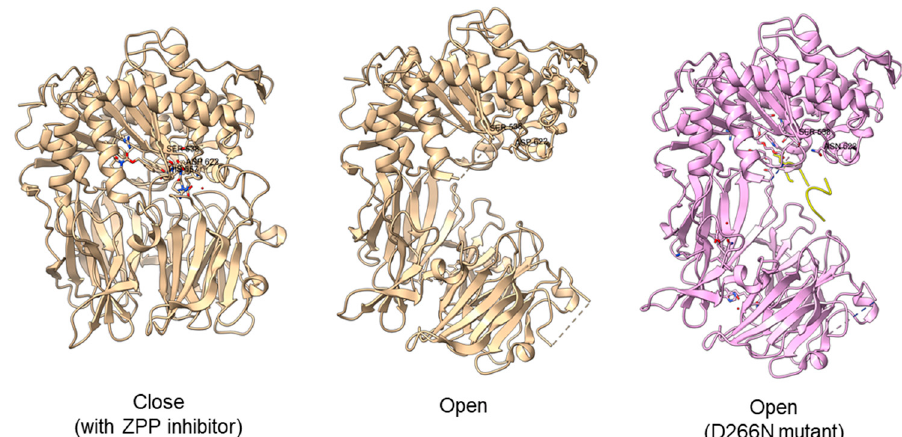
Figure 6. Crystal structures of Aeromonas punctata PEP (ApPEP). From left to right: close-state wild type ApPEP with ZPP inhibitor (PDB ID: 3IVM), open-state wild type ApPEP (PDB ID: 3IUL), mutant ApPEP with D266N mutation in an open state (PDB ID: 3IUR) induced by two H2H3 substrates (yellow). The catalytic triad (Ser538, Asp622, and His657) are labeled. However, the loops containing histidine catalytic residue (His657) are missing in the open-state crystal structures as they are unresolved in electron density maps and are inherently flexible.